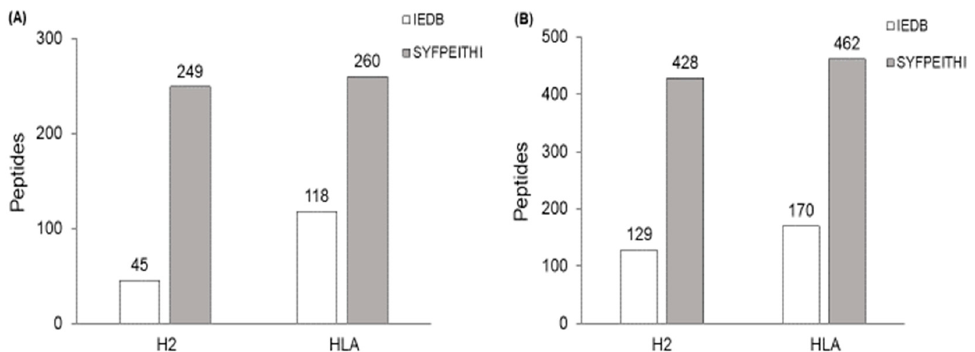
Figure 2. Epitope selection by the score value. Number of peptides predicted for LACK ( A ) and PEPCK ( B ) proteins after filtering by score value. Only peptides that reached scores ≥ 50% in at least